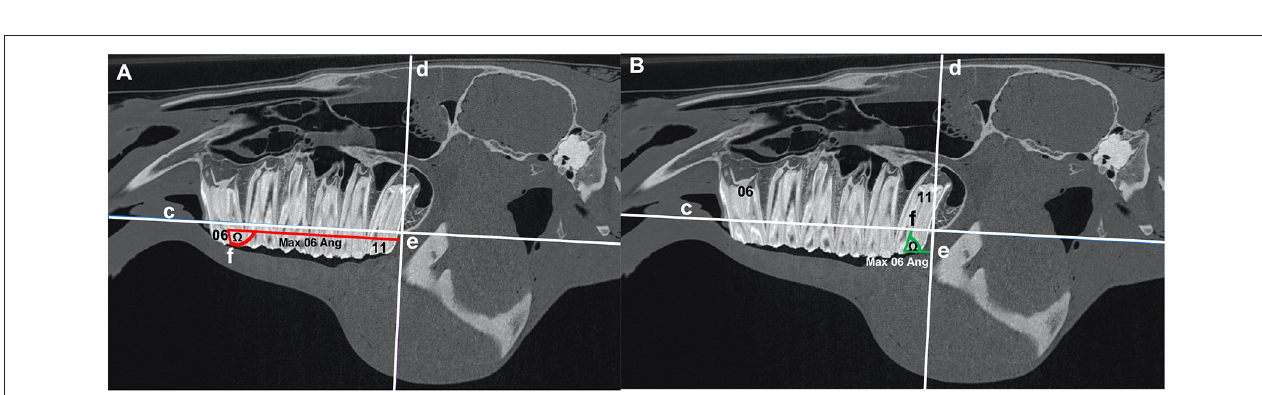
FIGURE 5 | (A) Sagittal CT image of an equine head showing line “c” that intersects the dorsal aspect of the maxillary bone immediately mesial to the maxillary second premolar (Triadan 06) tooth and the dorsal aspect of the maxillary bone immediately distal to the maxillary third molar (Triadan 11) tooth. Line “d” is at the level of the rostral orbit and lies perpendicular to line “c.” The red line “f” drawn through the central long axis of maxillary Triadan 06 intersects line “e” that lies parallel to line “c” and perpendicular to line “d.” The angle ( (cid:127) ) created by the intersection of line “f” and line “e” was measured (Max 06 Ang). (B) Sagittal CT image of an equine head showing line “c” that intersects the dorsal aspect of the maxillary bone immediately mesial to the maxillary second premolar (Tridan 06) tooth and the dorsal aspect of the maxillary bone immediately distal to the maxillary third molar (Triadan 11) tooth. Line “d” at the level of the rostral orbit lies perpendicular to line “c.” The green line “f” drawn through the central long axis of the maxillary Triadan 11 intersects line “e” that lies parallel to line “c” and perpendicular to line “d.” The angle ( (cid:127) ) created by the intersection of line “f” and line “e” was measured (Max 11 Ang).